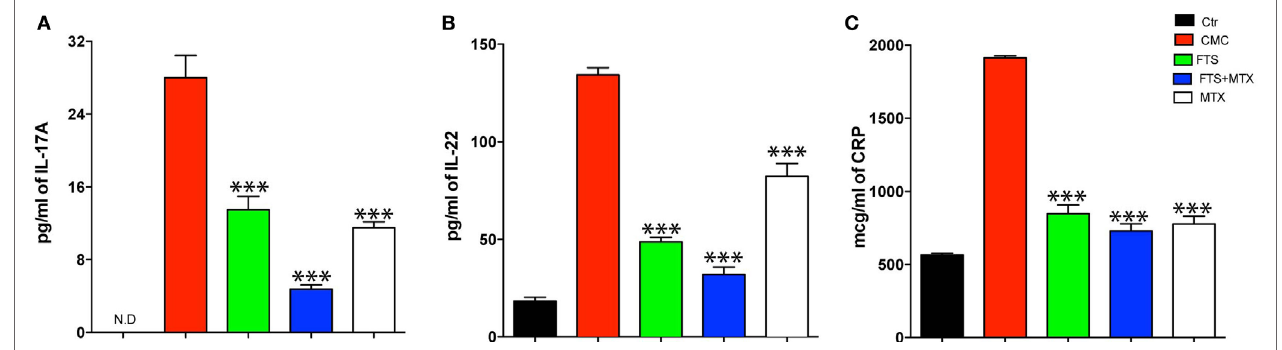
FigUre 2 | Farnesylthiosalicylic acid (FTS) treatment reduces serum Th17-cytokines and CRP levels during arthritis development. Sera from rats treated with carboxymethyl cellulose (CMC), FTS, FTS + MTX, or MTX was collected at Day 14 post adjuvant injection (day + 3 from arthritis onset) and analyzed for (a) IL-17A, (B) IL-22, and (c) CRP levels by ELISA kits. Bars represent mean ± SD of triplicates from a representative experiment out of three performed ( n = 4 rats analyzed per group). ND, not detectable. Statistical significance among groups was analyzed by the Student’s t -test (* P ≤ 0.05, ** P ≤ 0.01, and *** P ≤